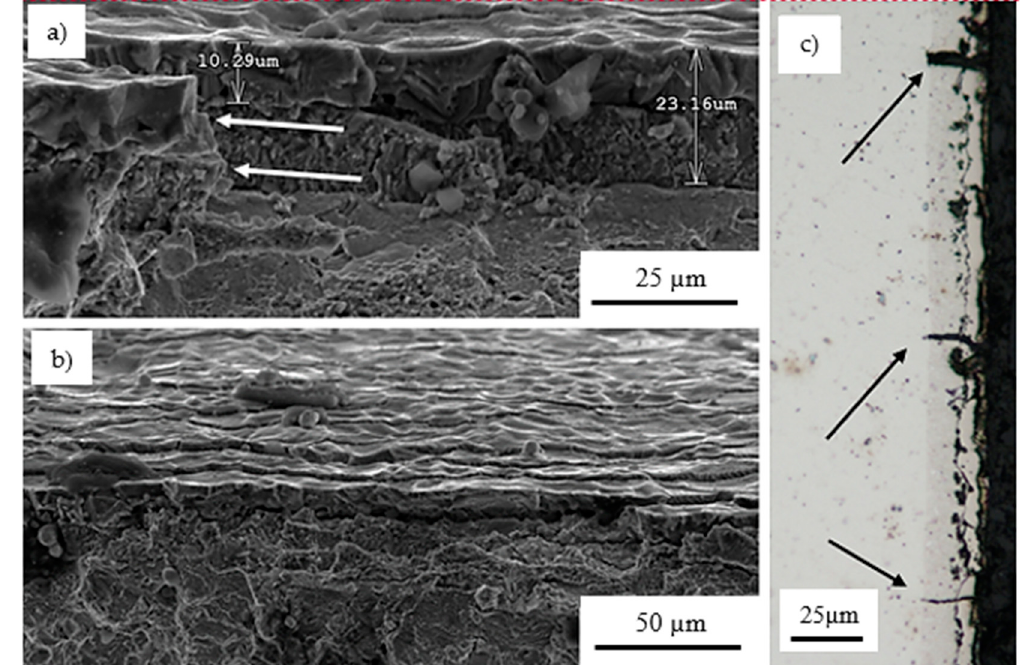
Figure 6. Fracture surface observations: ( a ) propagation of crack through coating without visible cracks in core material; ( b ) morphology of coating after fatigue at room temperature; ( c ) multiple layer cracks.